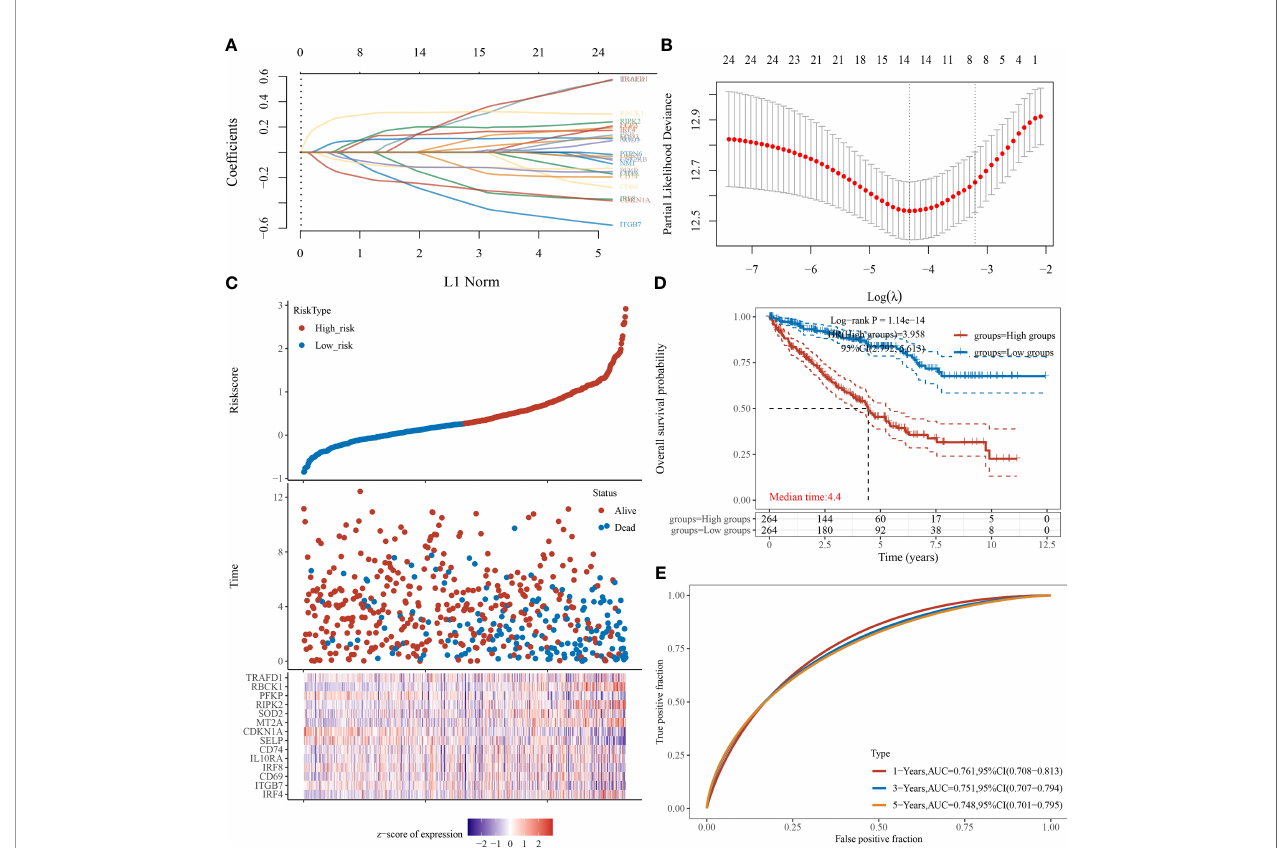
FIGURE 4 | IPMs predicting the OS of ccRCC. (A) Coef fi cients of the 24 IFN- g response signatures are displayed by the lambda parameter. (B) Partial likelihood deviance versus log ( l ) was drawn using LASSO Cox regression model. (C) The dotted line represented the median risk score and divided the patients into low-risk and high-risk groups. (D) Risk score of the 24 IPMs for predicting OS of ccRCC patients from TCGA was displayed using Kaplan – Meier curves. p -values and hazard ratio (HR) with 95% con fi dence interval (CI) were generated by log-rank tests and univariate Cox proportional hazards regression. (E) Time-dependent ROC analysis of the IPMs was generated predicting 1-, 3-, and 5-year survival